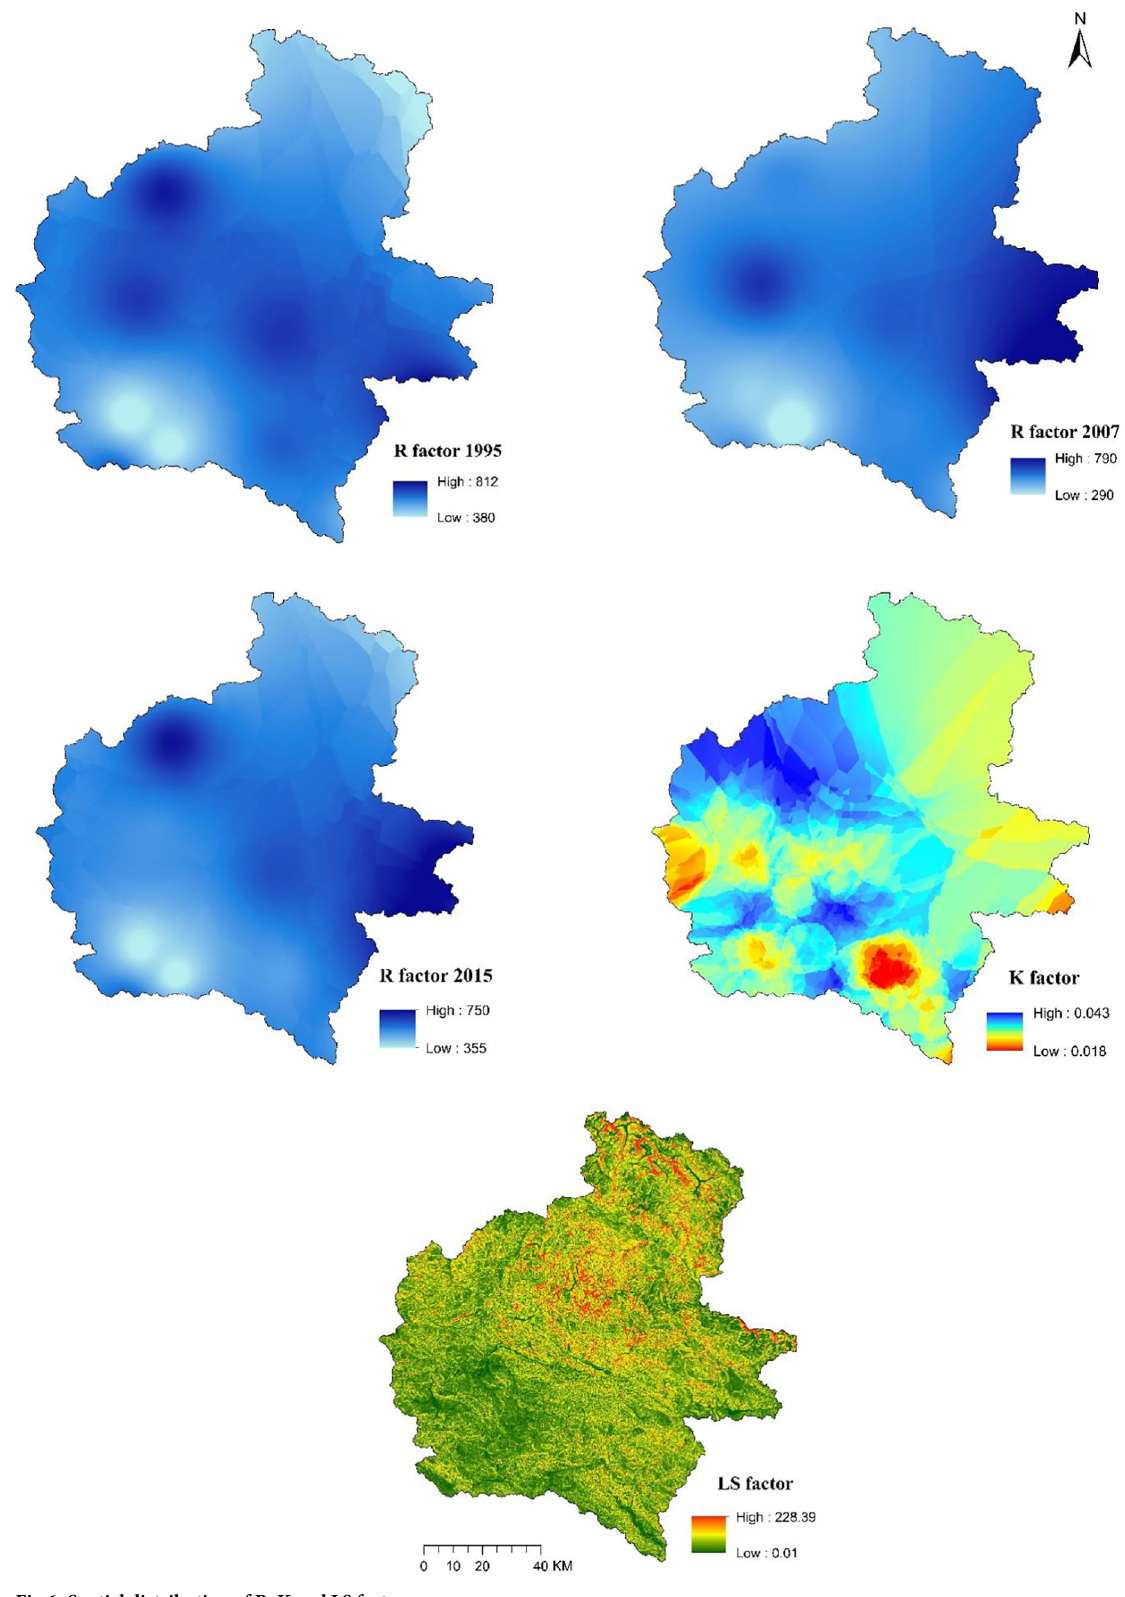
Fig 6. Spatial distribution of R, K and LS factor. https://doi.org/10.1371/journal.pone.0231692.g006 PLOS ONE | https://doi.org/10.1371/journal.pone.0231692 April 15,